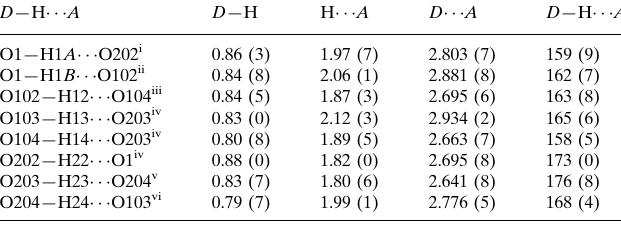
Hydrogen-bond geometry (A˚ , (cid:2)